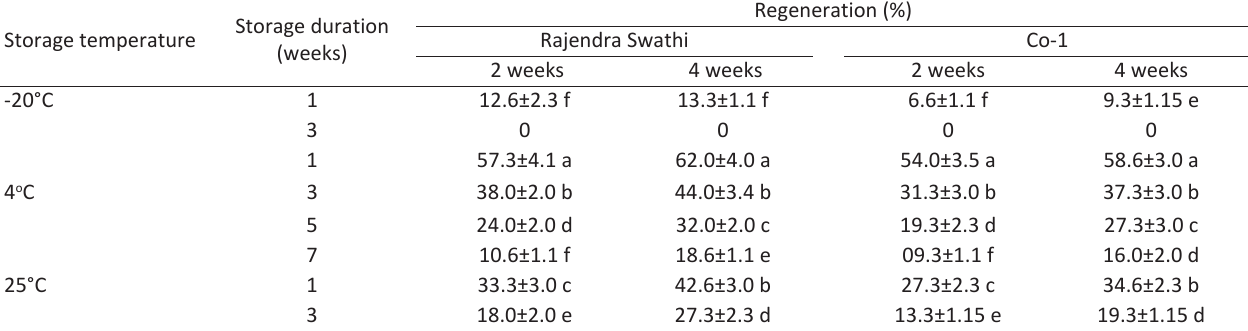
4 - Conversion rate at temperature conditions of somatic embryos encapsulated in 3% sodium alginate and 100 mm CaCl 2 , after storage. MS was added with 1.0 mg/l BA and 0.5 mg/l GA 3